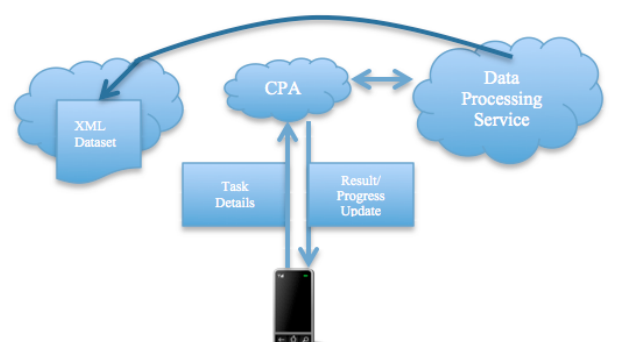
Figure 3. The user sends the data processing details, including the URL of the XML dataset, to the CPA. The CPA then contacts the cloud data processing service with the details, which begins the processing. The result is sent back to the CPA. The user can also receive progress